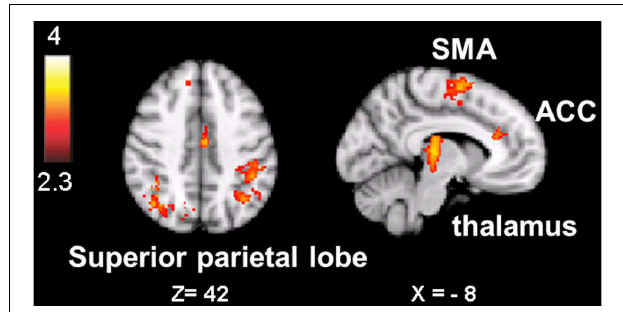
FIGURE 4 | Spatial overlap map of clusters of activation on group-level that survived, within each participant’s native functional space, both the threshold for the awareness contrast and the threshold for salience processing. Analyses were we constrained by creating for each individual an “error awareness brain mask” within which activation was sensitive to salience processing. Renderings (on MNI stereotactic space) are thresholded at z = 2.3 and p = 0.05. Note: ACC, anterior cingulate cortex; SMA, supplementary motor